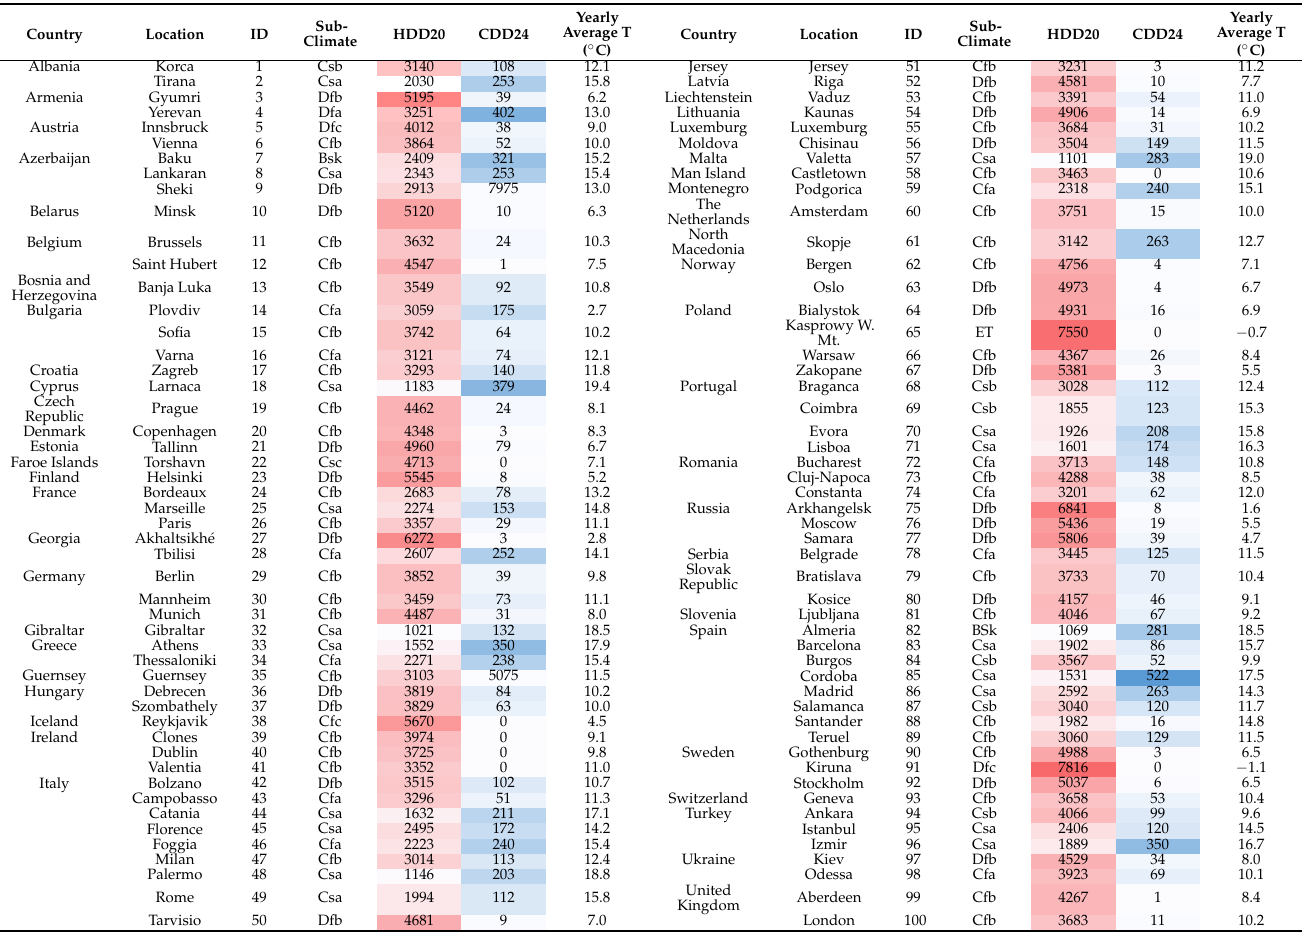
Table 1. Heating and cooling degree-days, yearly average temperature and identification for the 100 selected locations in Europe sorted by country and climate type (darker colours means higher HDD/CDD